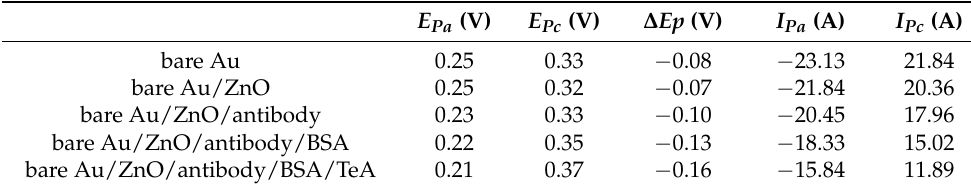
Table 1. Comparison table of characterization results.